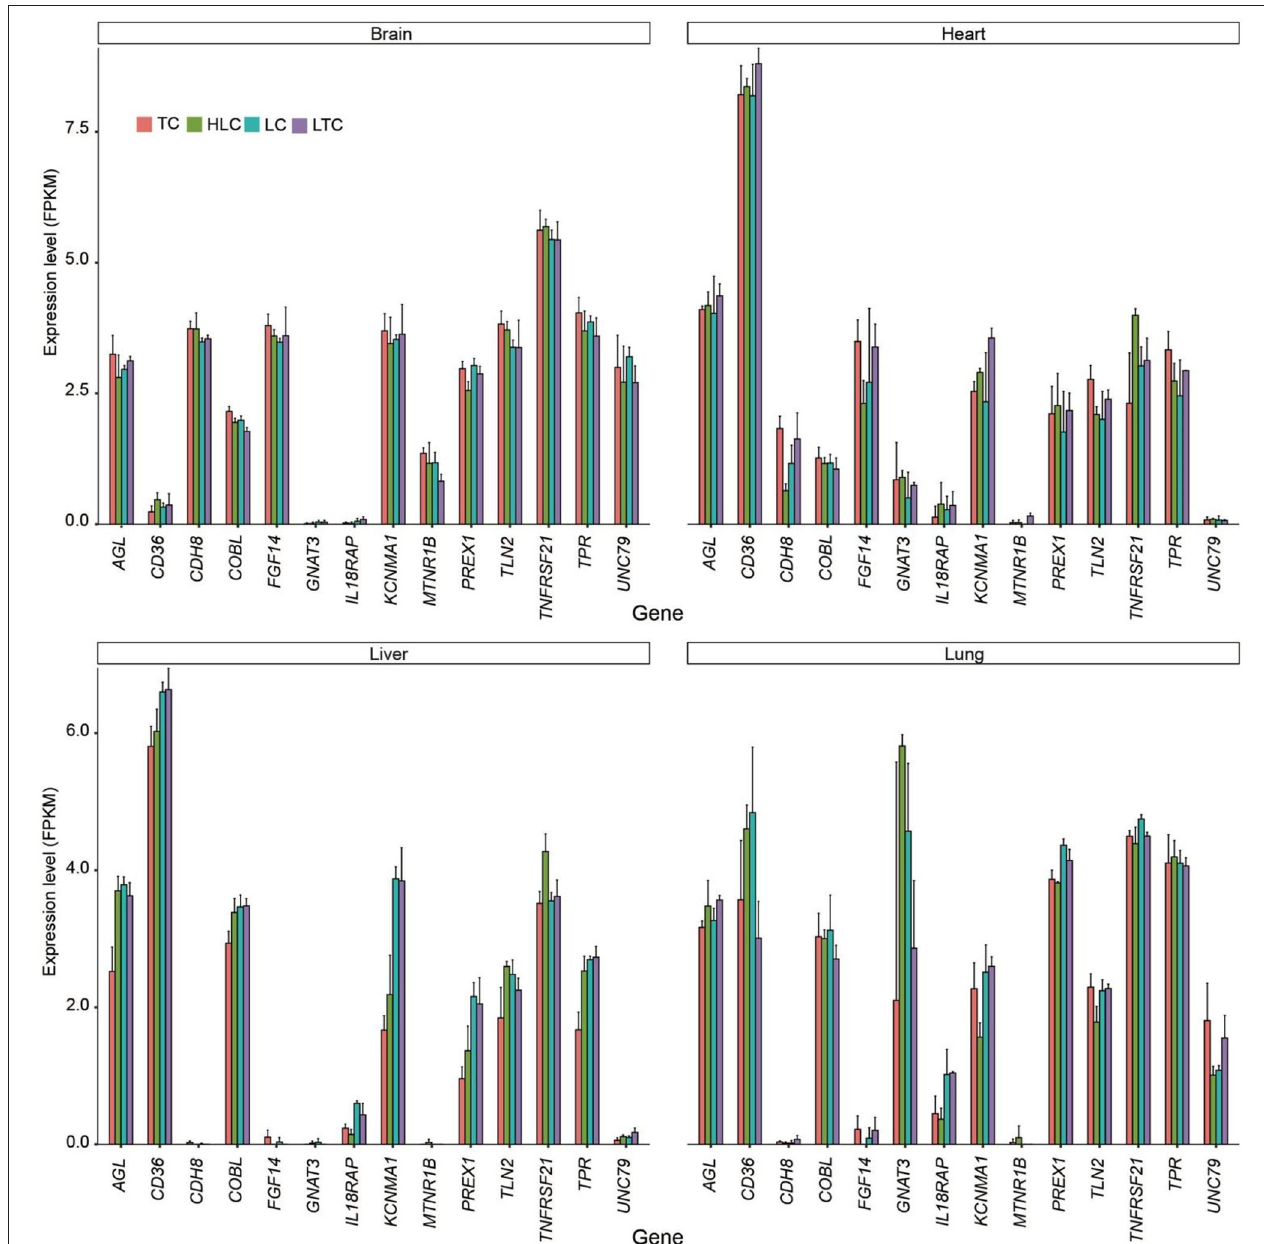
FIGURE 7 | The expression level (log 2 FPKM) of selected genes in four